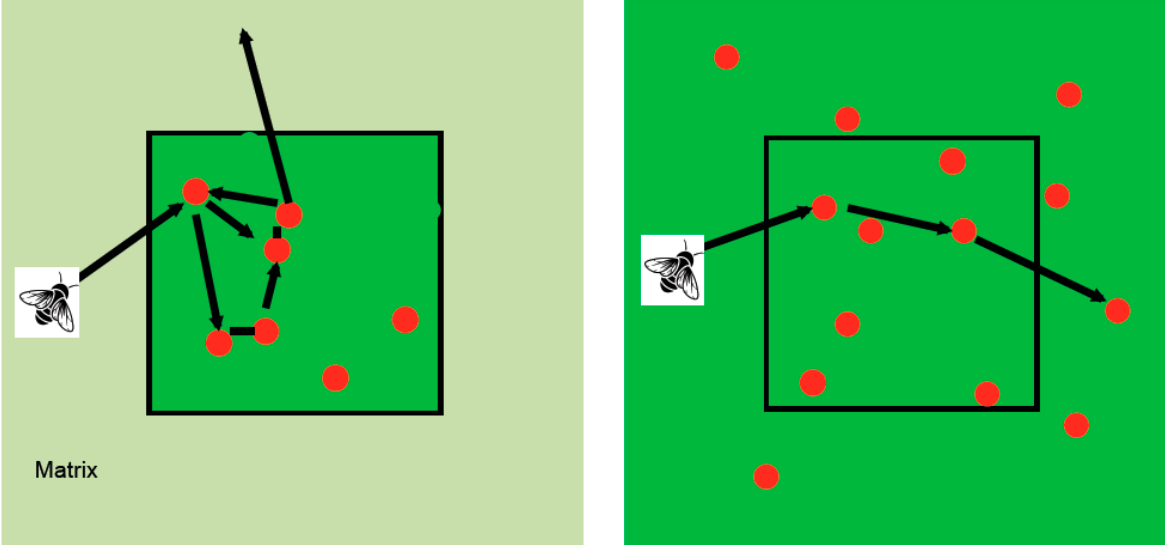
Figure 7. Foraging behavior of bumblebees in a small fragment and control plot. Red dots represent the positions of single Stachys officinalis inflorescences. In fragments, bumblebees visited repeatedly the same inflorescences during a trip, considering almost all inflorescences. In contrast, in control plots, inflorescences were only visited once [51].